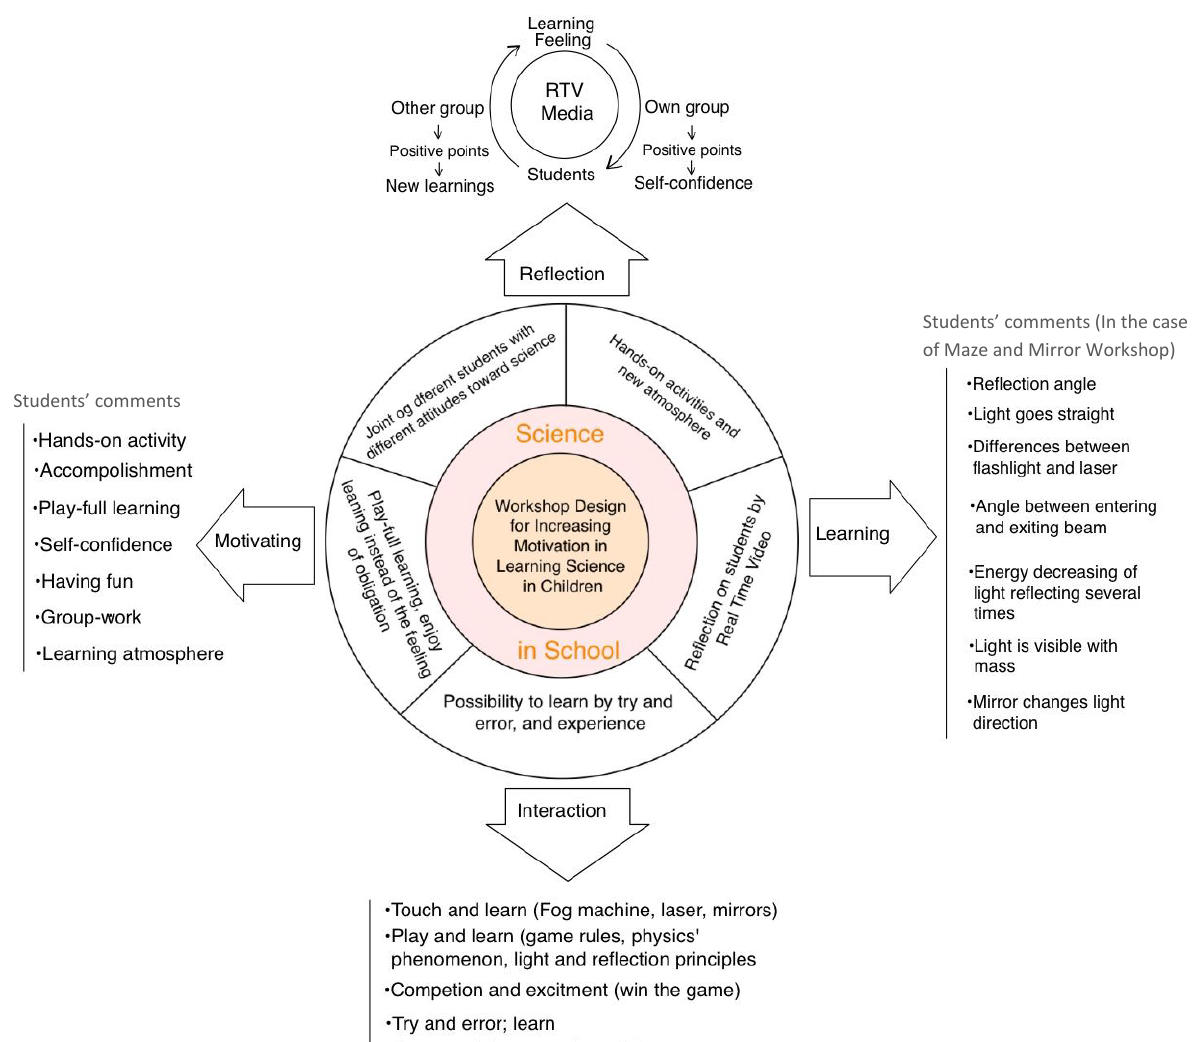
Figure 17 Maze and Mirror game and concluding factors considering students' interaction with the